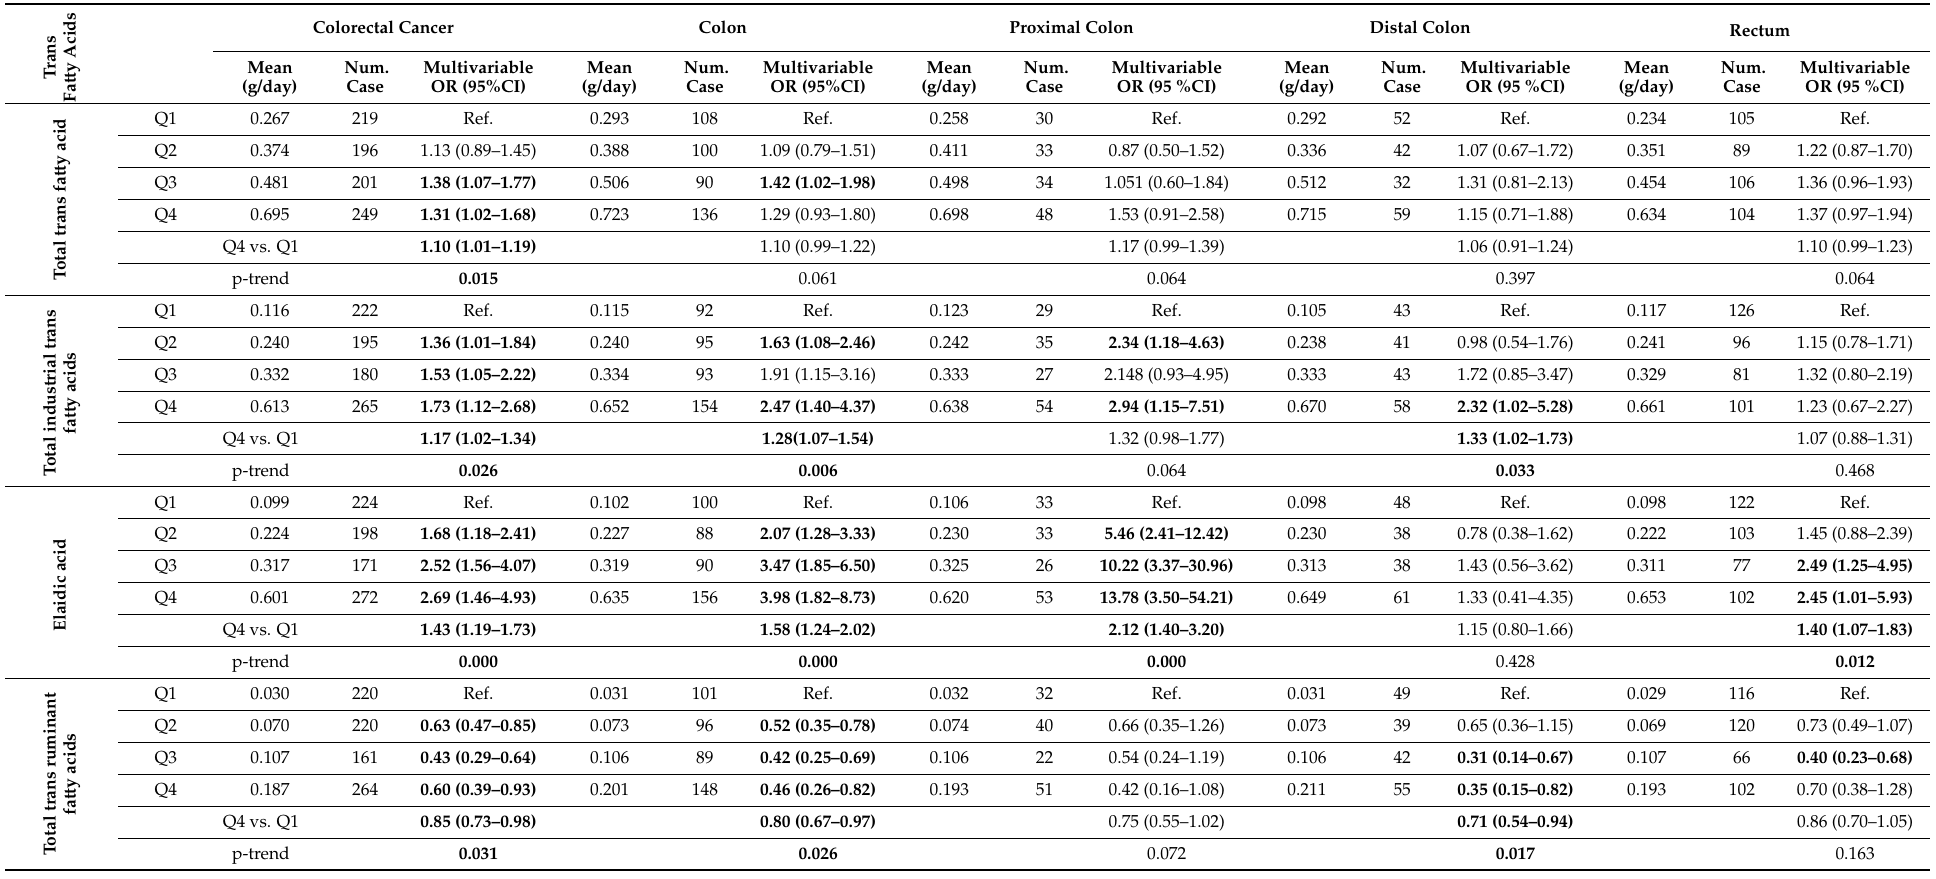
Table 2. Odds ratios and 95% confidence intervals of the association between dietary intake of trans fatty acids and colorectal cancer risk, by anatomical